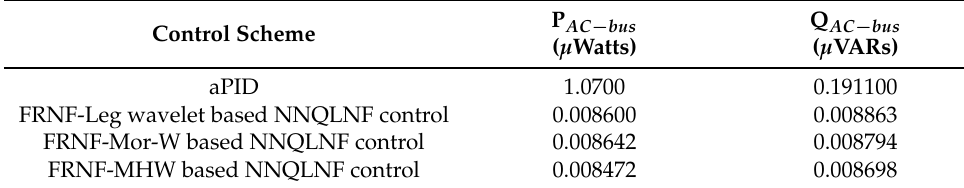
Table 2. Average values of ∆ P AC − bus and ∆ Q AC − bus variations for all